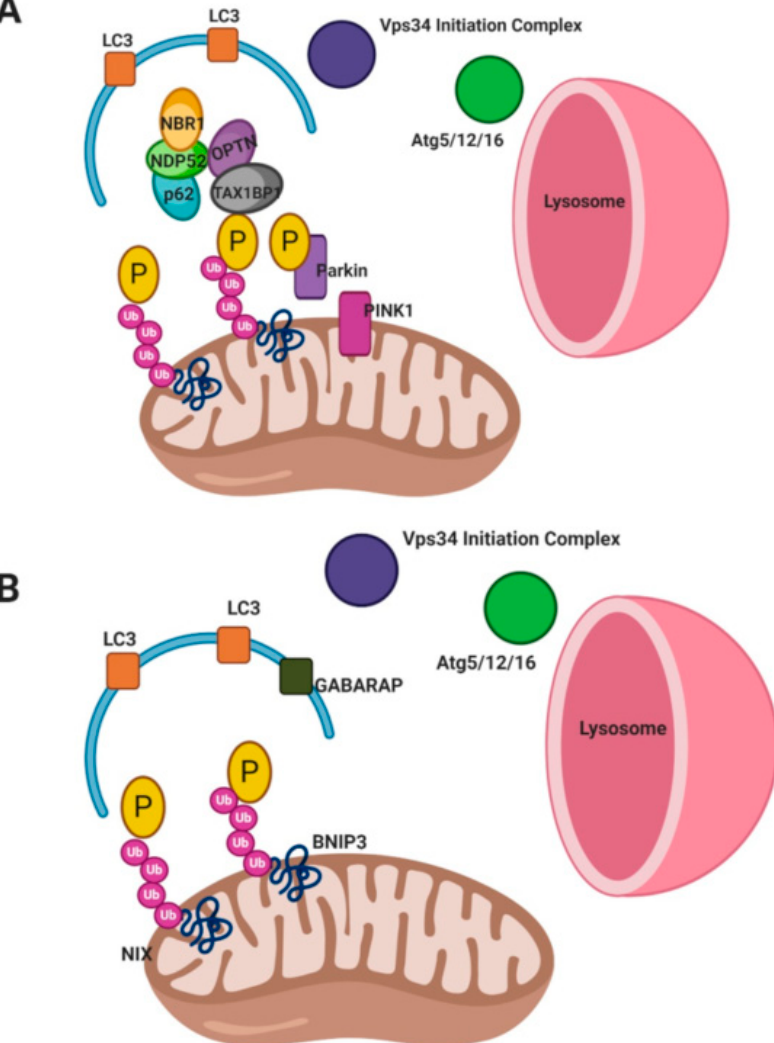
Figure 2. Mitophagy. ( A ) Non-Receptor Mediated Mitophagy or Classical Mitophagy. Activation of PINK1 leads to recruitment of ubiquitin and Parkin. Parkin ubiquitinates and phosphorylates mitochondrial proteins (such as VDAC, MFN1 / 2, and TOM20) and this initiates receptor adaptor protein recruitment (p62, NDP52, OPTN, TAX1BP1, and NBR1). These adaptor proteins interact with LC3 to form the autophagosome. The Vps34 and Atg5 / 12 / 16 complex facilitate autophagosome maturation, closure, and lysosome fusion [44,50] ( B ) Receptor Mediated Mitophagy. Mitochondrial receptor proteins (BNIP3, NIX, FUNC1, AMBRA1, PHB2, or cardiolipin) are ubiquitinated and phosphorylated. This facilitates their interaction with LC3 and GABARAP for autophagosome formation. The Vps34 and Atg5 / 12 / 16 complex facilitate autophagosome maturation, closure, and lysosome fusion [44,50]. Created with BioRender.com.